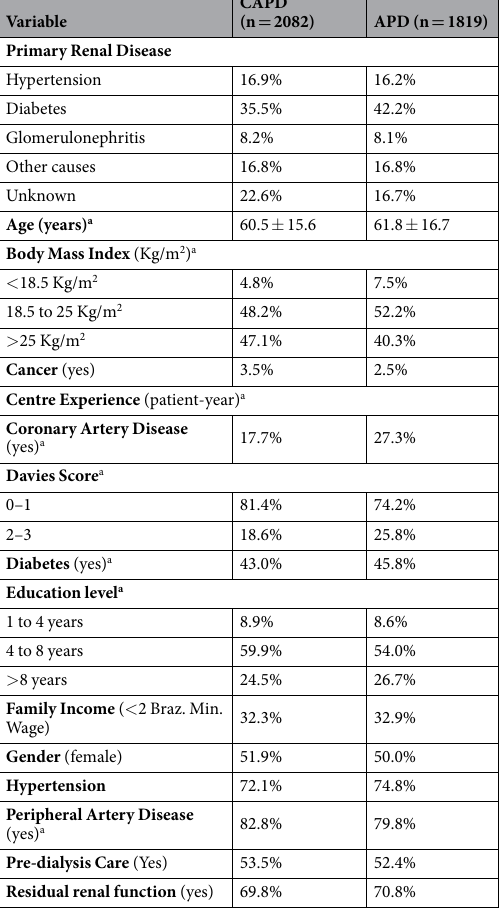
Covariates that reached statistical significance to be included in all models were year of initiation of PD (hereby called biennium), body mass index (BMI), previous history of cancer, hypertension, peripheral artery dis- ease (PAD) and literacy. Five interaction terms were included in the models with interaction terms: biennium and BMI, coronary artery disease and hypertension, hypertension and diabetes, biennium and literacy, and peripheral artery disease and literacy. Akaike information criterion for the multilevel model (ML) with interaction terms was 5587.427; for the ML model without interaction terms 5613.5; for the logistic regression (LR) model with interaction terms 5156.47; and for the LR without interaction terms 5232.82. Race. African American patients were less likely to start dialysis in APD in all four models compared to White patients: multilevel with interactions (odds ratio 0.77, CI95% 0.64–0.93), multilevel without interactions (odds ratio 0.76, CI95% 0.63–0.91), logistic regression with interaction terms (odds ratio 0.68, CI95% 0.59–0.79) and logistic regression without interactions (0.67, CI95% 0.58–0.77). The same difference was not observed for Asians in any of the models: multilevel with interactions (Odds ratio 1.32, CI95% 0.82–2.13), ML without interactions (Odds ratio 1.41, CI95% 0.88–2.26), LR with interactions (Odds ratio 1.08, CI95% 0.73–1.61), LR without inter-